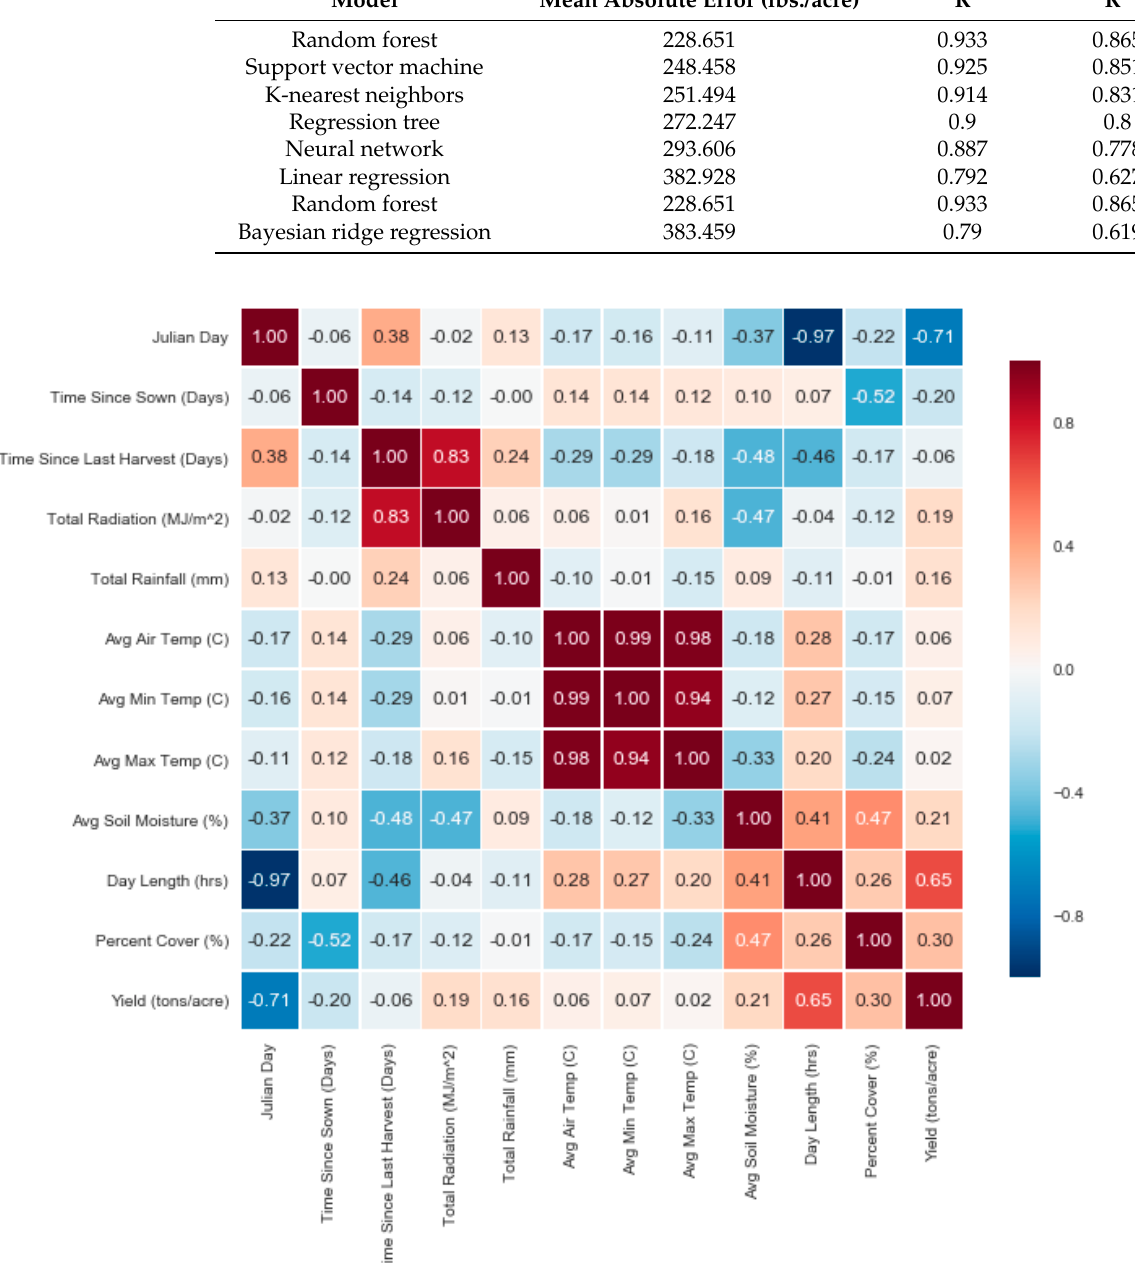
Table 4. Results from Cfs feature selection with all features. These average scores are from using the features Julian day, total solar radiation, total rainfall, and percent cover.